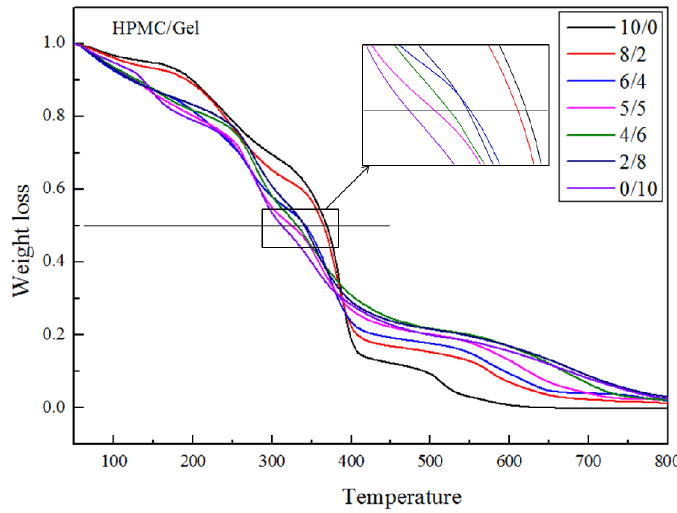
Figure 2. TGA thermogram of blending films.